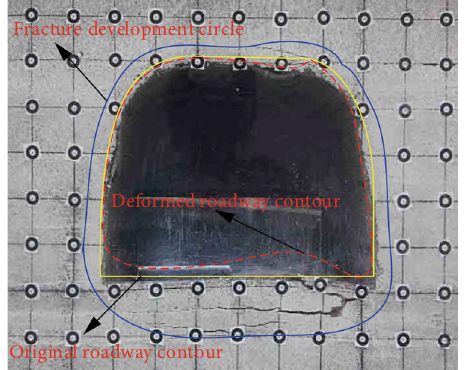
Figure 6: Roadway outline during slow deformation.